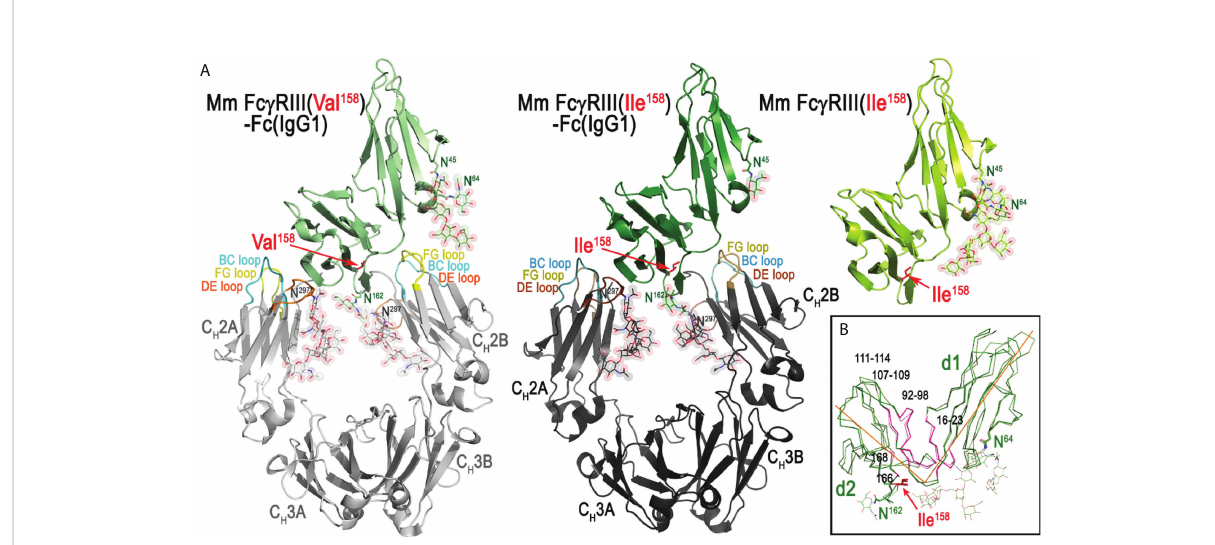
FIGURE 2 The structures of Rhesus macaque, Macaca mulatta (Mm), Fc g RIII(Val 158 )-Fc(IgG1), Fc g RIII(Ile 158 )-Fc(IgG1), and Fc g RIII(Ile 158 ) (apo). (A) Structures are shown in a ribbon diagram with the three macaque Fc g RIII receptors in light green (Fc g RIII-Val 158 , top left structure), dark green (Fc g RIII- Ile 158 , middle structure), and lime (apo Mm Fc g RIII-Ile 158 , top right structure), and the two heavy chains (C H 2-C H 3 domains) in light gray (Mm Fc g RIII(Val 158 )-Fc) and dark gray (Mm Fc g RIII(Ile 158 )-Fc). Sugars attached to Asn 297 , Asn 162 , Asn 45 and Asn 64 are shown as spheres colored by atom type (backbone color for carbon, red for oxygen and blue for nitrogen). The BC, DE, and FG loops of C H 2 domain in Fc g RIII(Val 158 )-Fc (IgG1) and Fc g RIII(Ile 158 )-Fc(IgG1) structures are colored in lighter and darker shades of cyan, yellow, and orange, respectively. The two heavy chain monomers are labeled as A and B chains. (B) Superimposition of Mm Fc g RIII(Ile 158 ) receptor from Fc g RIII(Ile 158 )-Fc(IgG1) complex structure onto the apo Mm Fc g RIII(Ile 158 ) to show conformational differences. Only main chain atoms are shown as ribbons with colors for the receptor as in panel (A) Ile 158 and glycosylation site residues (Asn 45 , Asn 64 , and Asn 162 ) are shown as sticks.